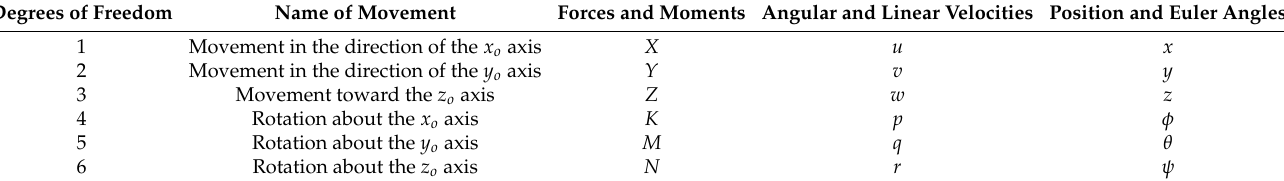
Table 1. Notation used in describing the movement of underwater